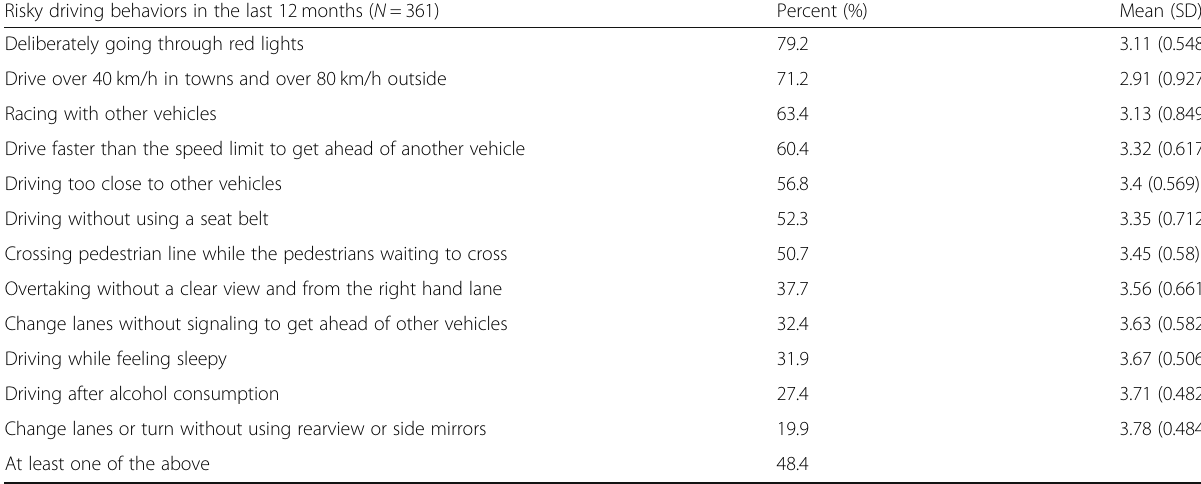
Table 2 Risky driving behaviors among professional car drivers in Bahirdar city, Ethiopia, 2016 Risky driving behaviors in the last 12 months ( N =